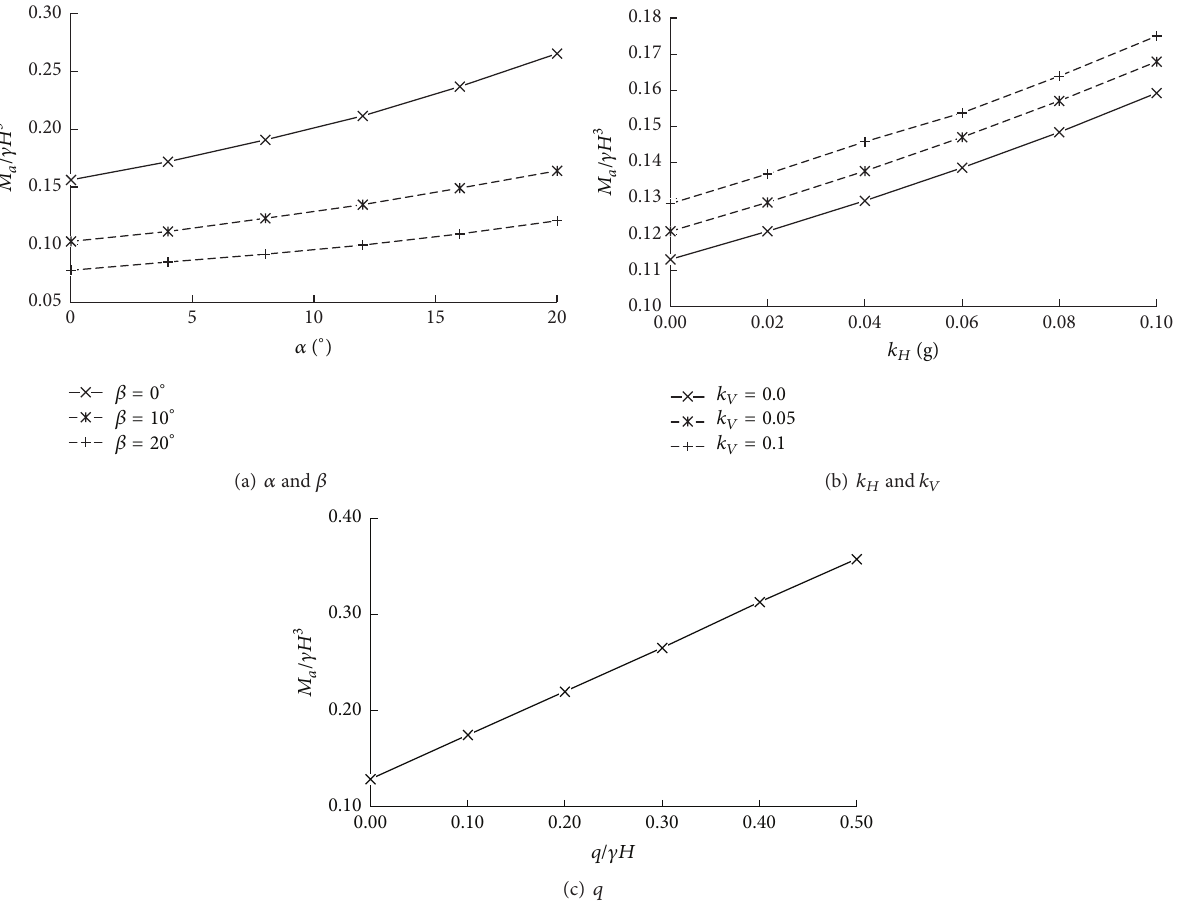
Figure 8: Effects of relevant parameters on 𝑀 𝑎